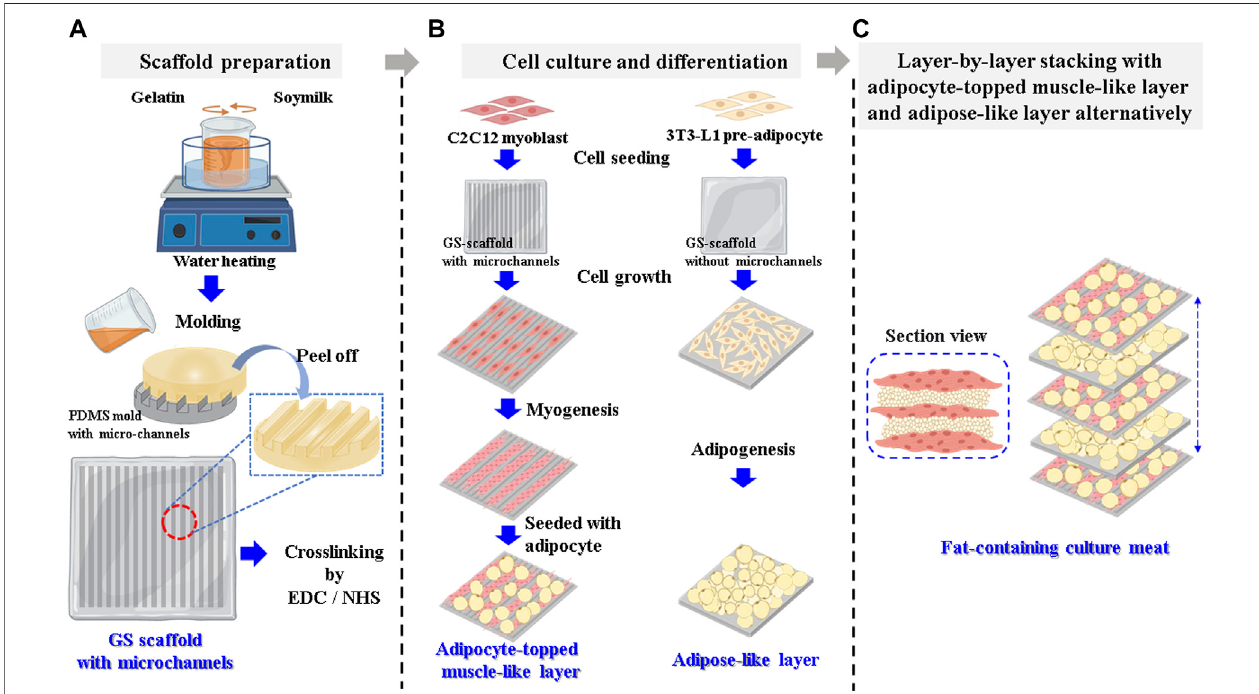
GRAPHICAL ABSTRACT | Scheme for cultured meat preparation (A) Gelatin – soymilk solution is prepared and then put on the PDMS mold to prepare a GS scaffold with parallel microchannels. (B) The C2C12 myoblasts and 3T3-L1 pre-adipocytes are seeded on the GS scaffold to prepare adipocyte-topped muscle-like layers and adipose-like layers. (C) The two layers are then stacked layer by layer to assemble into cultured meat containing fat.